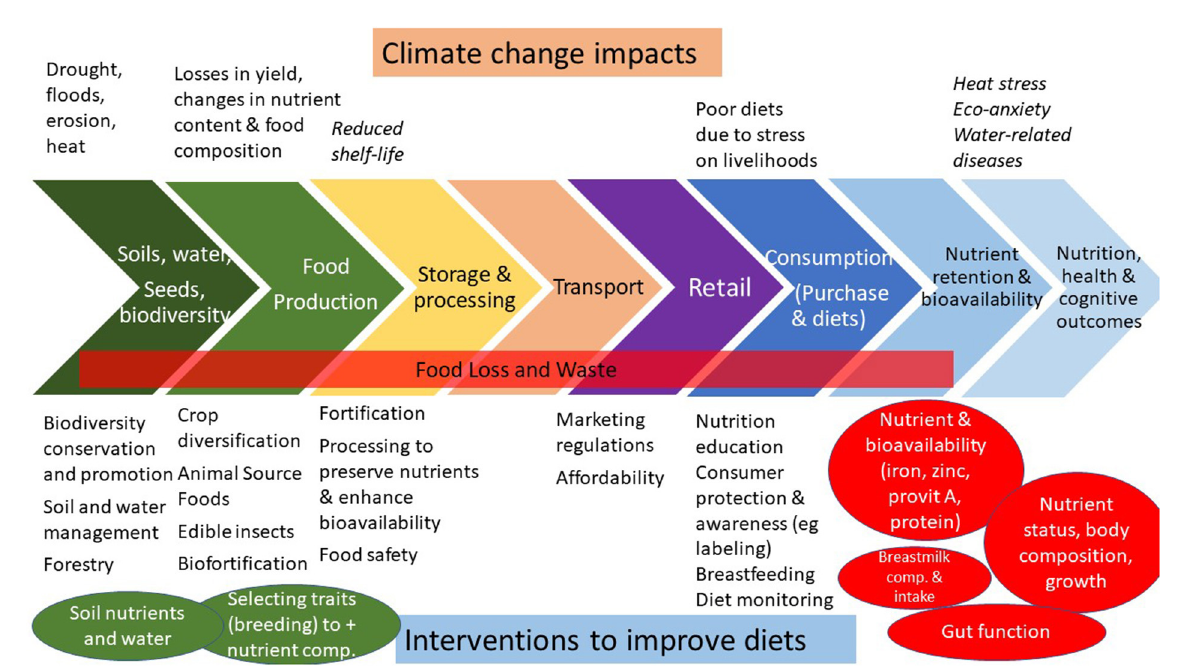
FIGURE1 A food systems continuum and value chain schema to address the link between climate change and diet quality and identify entry opportunities for stable isotope techniques relating to soil, water, and seed biodiversity, food production, nutrient retention and bioavailability, and nutrition, health, and cognitive